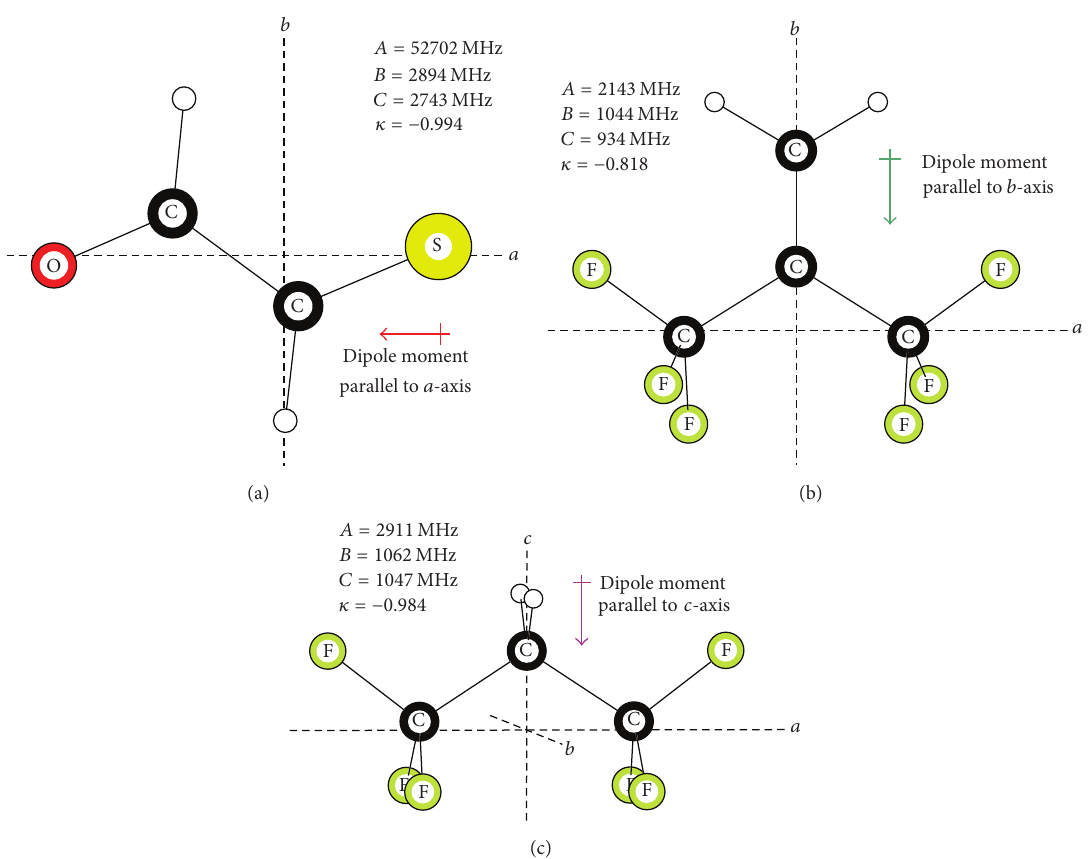
F 1: An example of three molecules in the principal axes system. e axis system is centered on the molecules center of mass. Notice how, in each case, the -axis is located such that it is as close to as much atomic mass as possible. As evidenced by the inset and rotational constants, all three molecules may be considered near-prolate asymmetric rotors. e directions of the dipole components for 𝑎𝑎𝑎𝑎𝑎𝑎 each molecule are shown. e lines between atoms indicate connectivity and not bond order. e three molecules are thioxoacetaldehyde (a), 𝑎𝑎 hexa�uoroisobutene (b), and 1,1,1,3,3,3-hexa�uoropropane